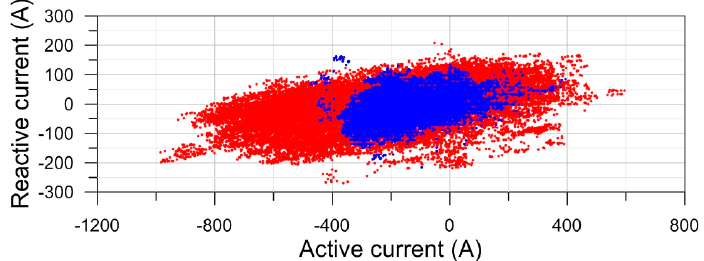
Figure 1. Scatterplot of active and reactive currents on a two ‐ circuit 200 kV/132 kV line, 15 min averages for one year. Red: 220 kV, blue: 132 kV. Source: report on the pilot project [15].